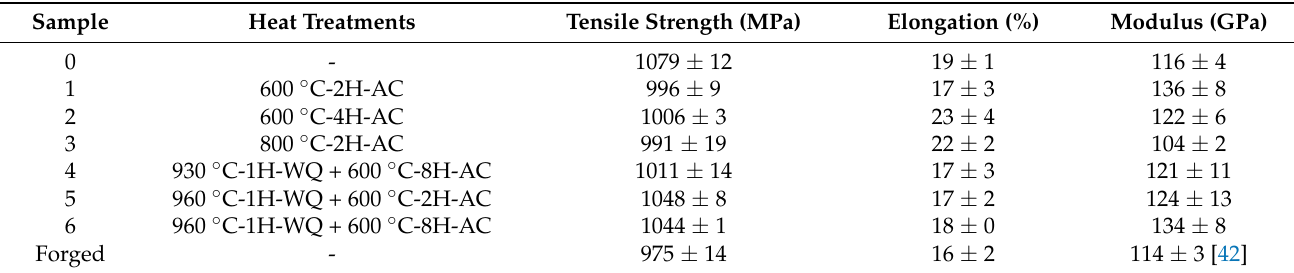
Table 5. Tensile properties of SLM TC4 under different heat